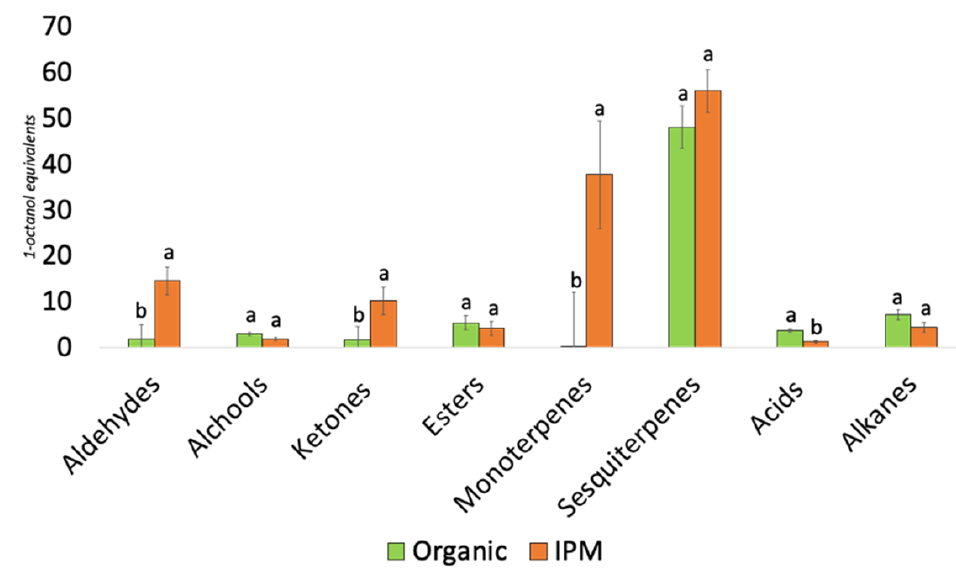
Figure 4. Canonical correlation analysis of bacterial genera discriminating organic from IPM grown fruit and quality parameters. Bacterial genera are coloured in brown, quality parameters in green. 3.3. Characterization of the Volatilome of Organic and Integrated Pest Management (IPM) Raspberry Fruits The GC–MS raspberry volatile profile revealed 32 and 37 VOCs released by organic and IPM fruits, respectively. Single VOCs were grouped according to their chemical characteristics in the following classes: alkanes, acids, mono- and sesquiterpenes, esters, ketones, alcohols and aldehydes (Figure 5; Table 3).